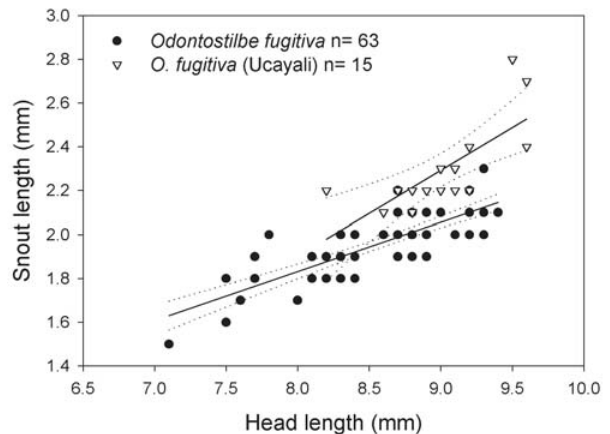
Fig 10. Snout length as a function of head length for males of Odontostilbe fugitiva , specimens widely distributed on rio Amazonas basin against specimens of río Ucayali